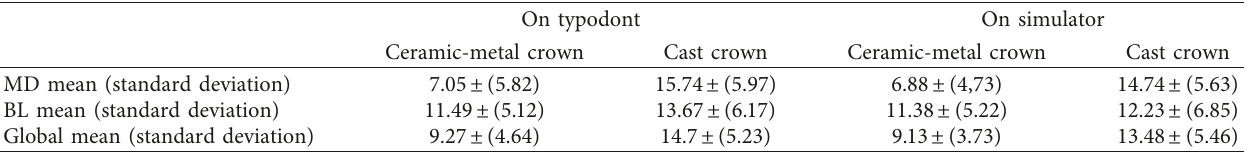
Table 4: Average TOC on typodont and simulator according to the type of